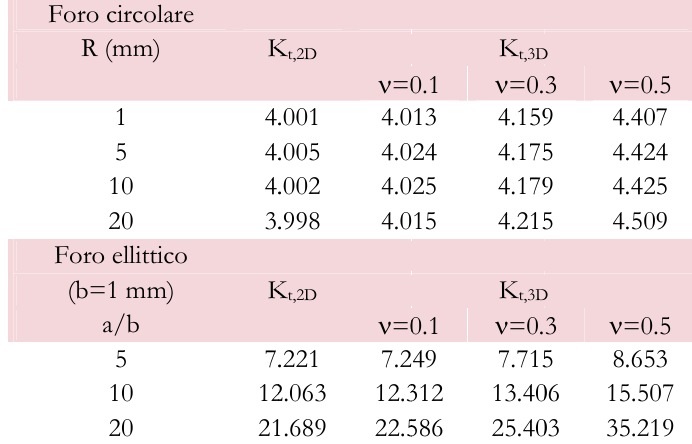
Tabella 1: Fa fine, in Tab. fferenti